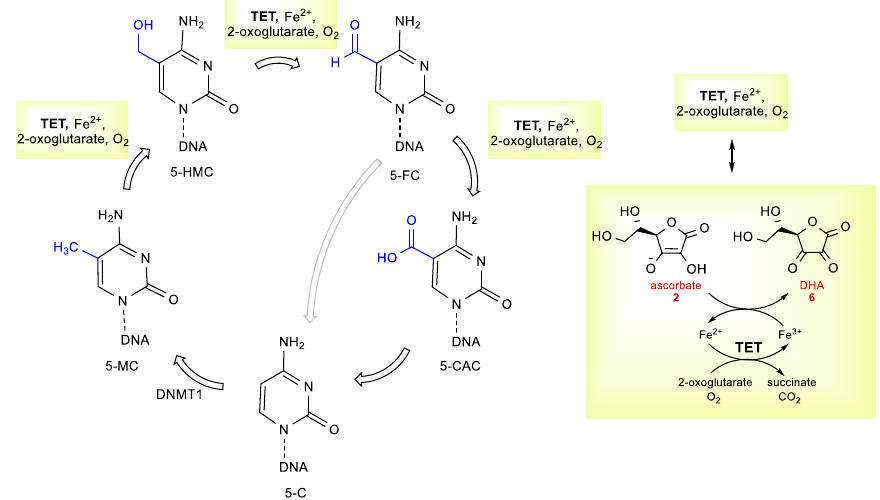
Figure3. ThemechanisticoverviewofascorbateinDNAdemethylation.5-HMC:5-hydroxymethylcytosine; Figure 3. The mechanistic overview of ascorbate in DNA demethylation. 5-HMC: 5-hydroxymethylcytosine; 5-MC: 5-methylcytosine; DNMT1: DNA methyltransferase 1; 5-C: 5-MC: 5-methylcytosine; DNMT1: DNA methyltransferase 1; 5-C: 5-cytosine; 5-CAC: 5-carboxylcytosine; 5-FC: 5-formylcytosine; TET: ten-eleven translocation